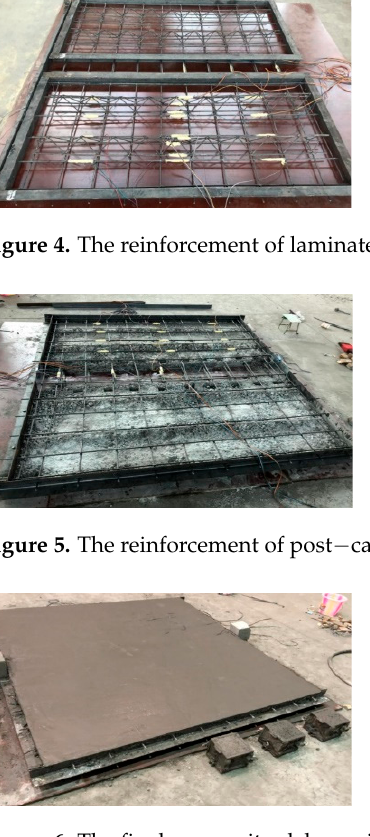
Figure 7. The keyway of the composite slab. Figure 8. 45 − degree bending angle seam of traditional composite slab. Figure 9. Overall seam form of the composite slab composite slab.